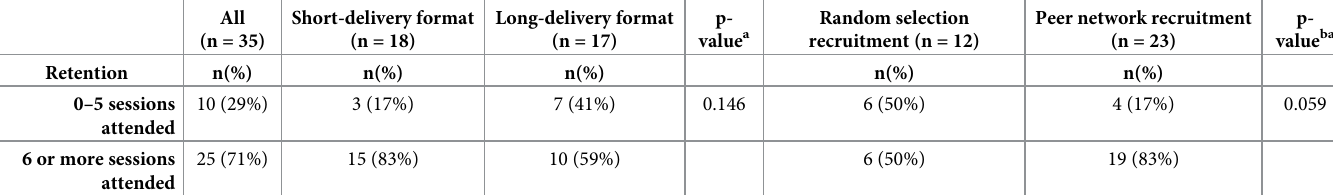
Table 2. Retention of participants in the intervention by intervention delivery and recruitment.